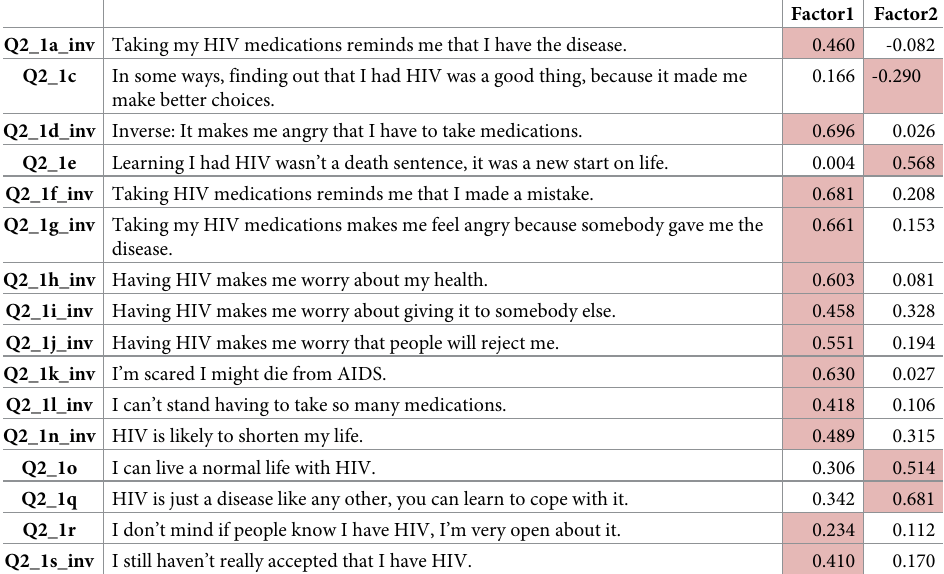
Table 1. Factor analysis of items pertaining to personal meanings of living with HIV. he instrument, 1 represents strong agreement and 4 represents strong disagreement. Therefore negatively framed items have had scores reversed. A negative score on a positively framed item indicates agreement.(Original variable names are shown to reveal the location of deleted items.). Q2_1a_inv Taking my HIV medications reminds me that I have the disease. 0.460 -0.082